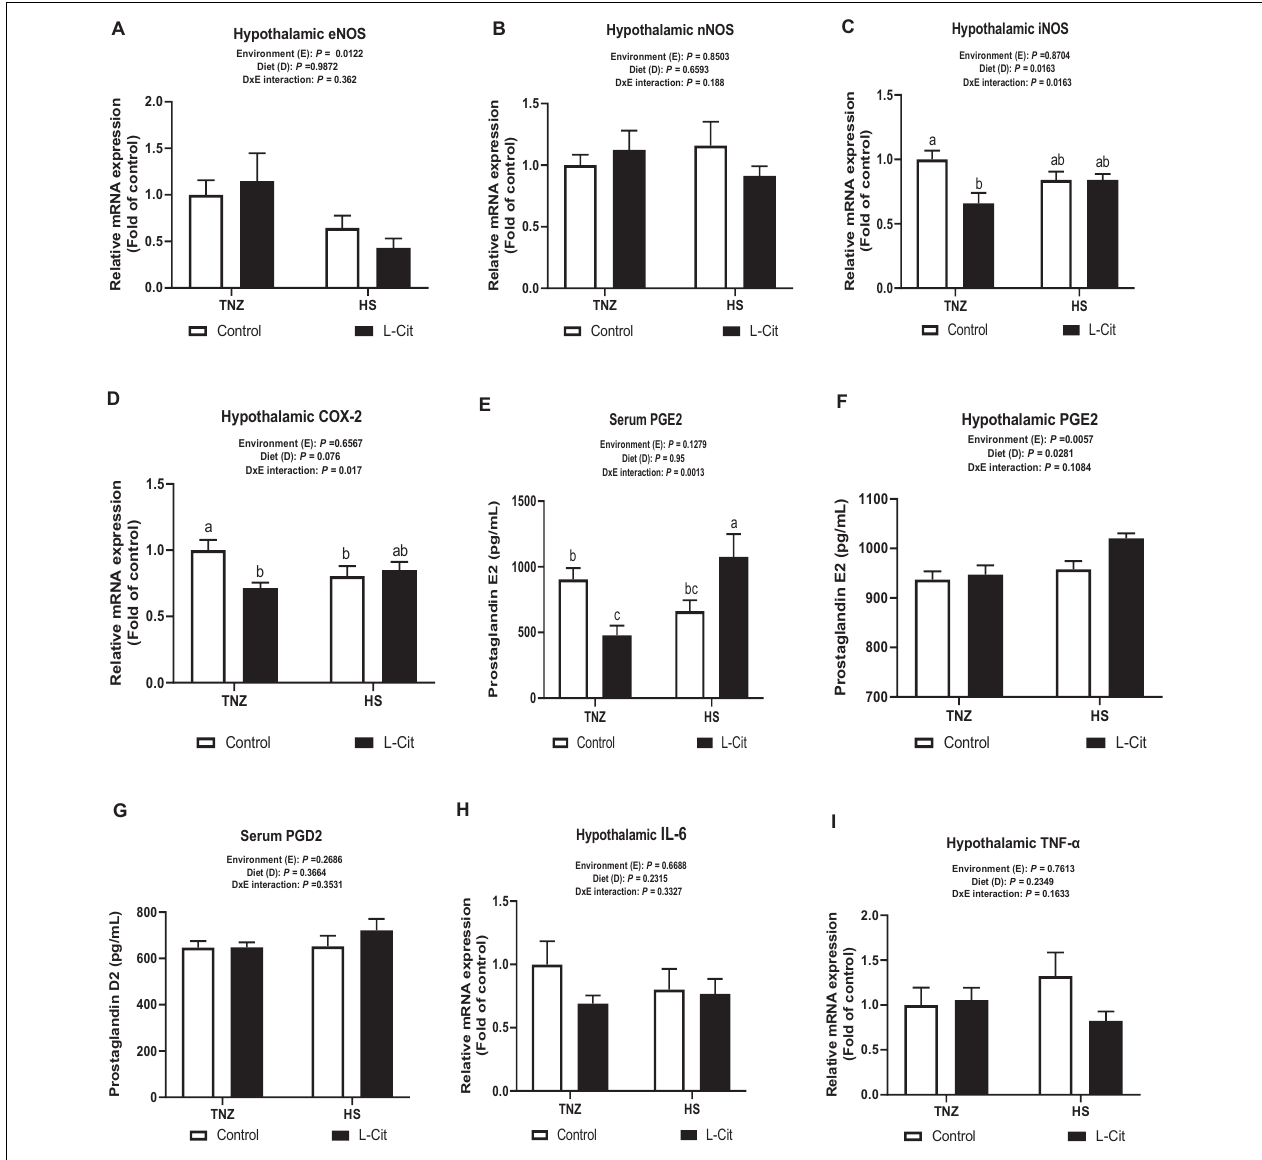
FIGURE 6 | L -Citrulline alters transcriptional expression of hypothalamic NOS2-COX2-PGE2 signaling. (A) Endothelial NOS isoform (eNOS). (B) Neuronal NOS isoform (nNOS). (C) Inducible NOS isoform (iNOS). (D) Cyclooxygenase 2 (COX-2). (E) Serum Prostaglandin E2 (PGE2). (F) Hypothalamic Prostaglandin E (PGE2). (G) Serum Prostaglandin D2 (PGD2). (H) Interleukin (IL)-6. (I) Tumor necrosis factor (TNF)- α . Data are presented as mean ± SEM ( n = 8). TNZ, thermoneutral; HS, heat stress. a , b , c Different letters indicate significant difference of D × E interaction at P <